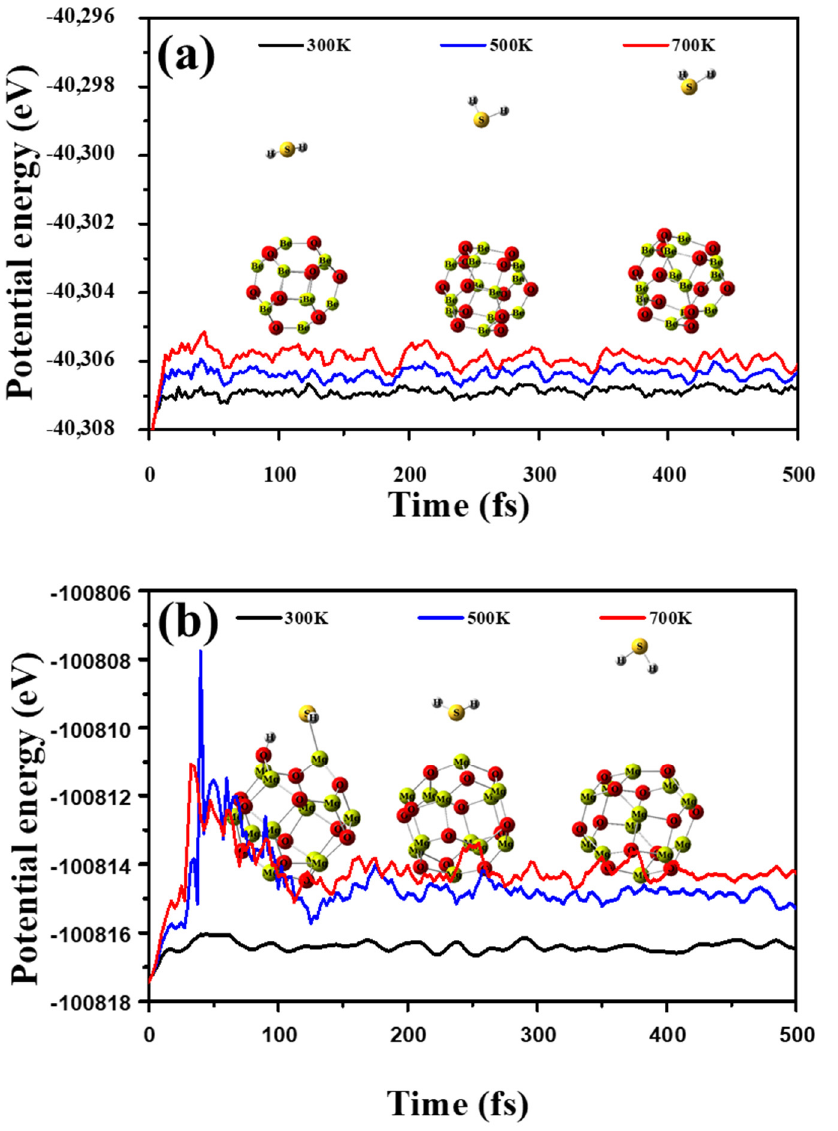
Figure 9. Potential energy fluctuations during MD simulation for ( a ) H 2 S/Be 12 O 12 , and ( b ) H 2 S/Mg 12 O 12 and the atomic configuration after 500 fs at 300, 500, and 700 K.